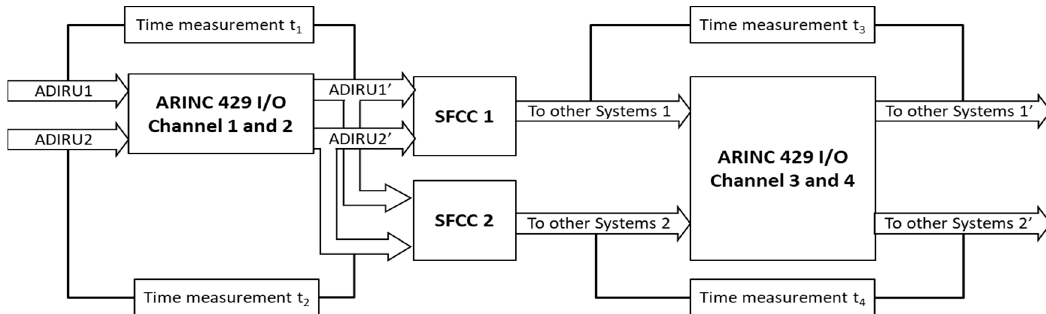
Figure 13. Setup for the time measurement.